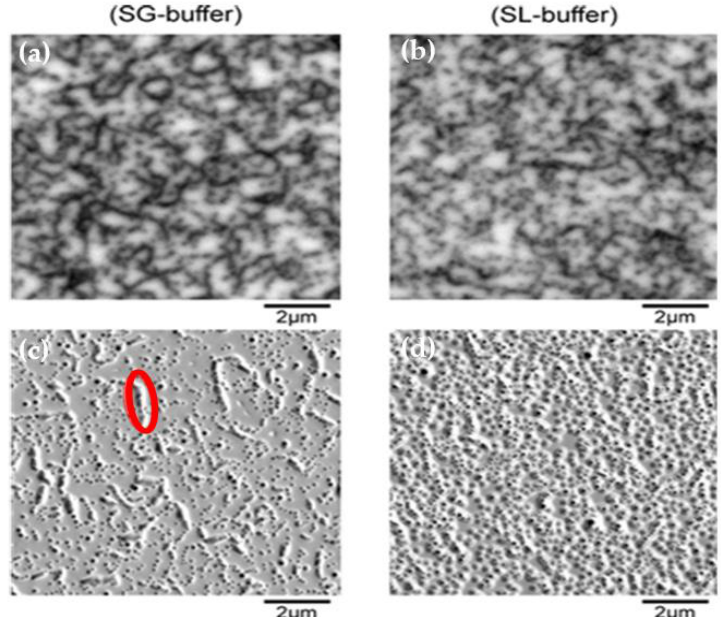
Figure 5. Representative CL mappings before defect selective etching (DSE) (first row) and SEM images collected after DSE (second row) on the two wafers (not the same place). On the step-graded (SG)-buffer sample extensive threading dislocation (TD)-clustering is observed (exemplarily marked by red ellipsis). ( a ) DSE on the reference wafer; ( b ) DSE on the SL wafer; ( c ) SEM image collected after DSE on the reference wafer; ( d ) SEM image collected after DSE on the SL wafer.